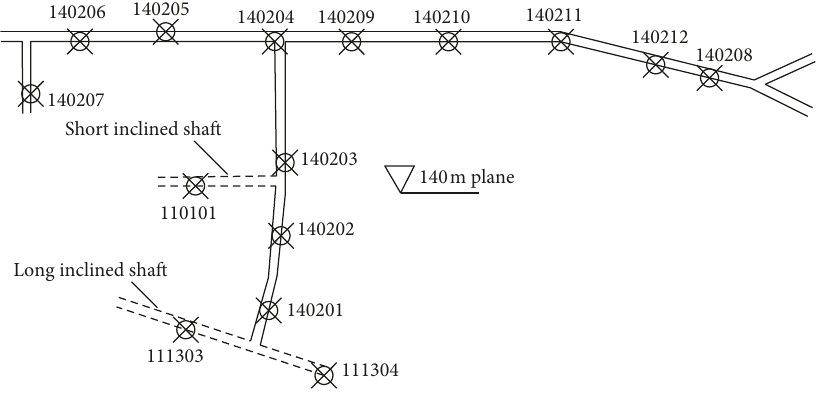
Figure 3: 140m plane sensor